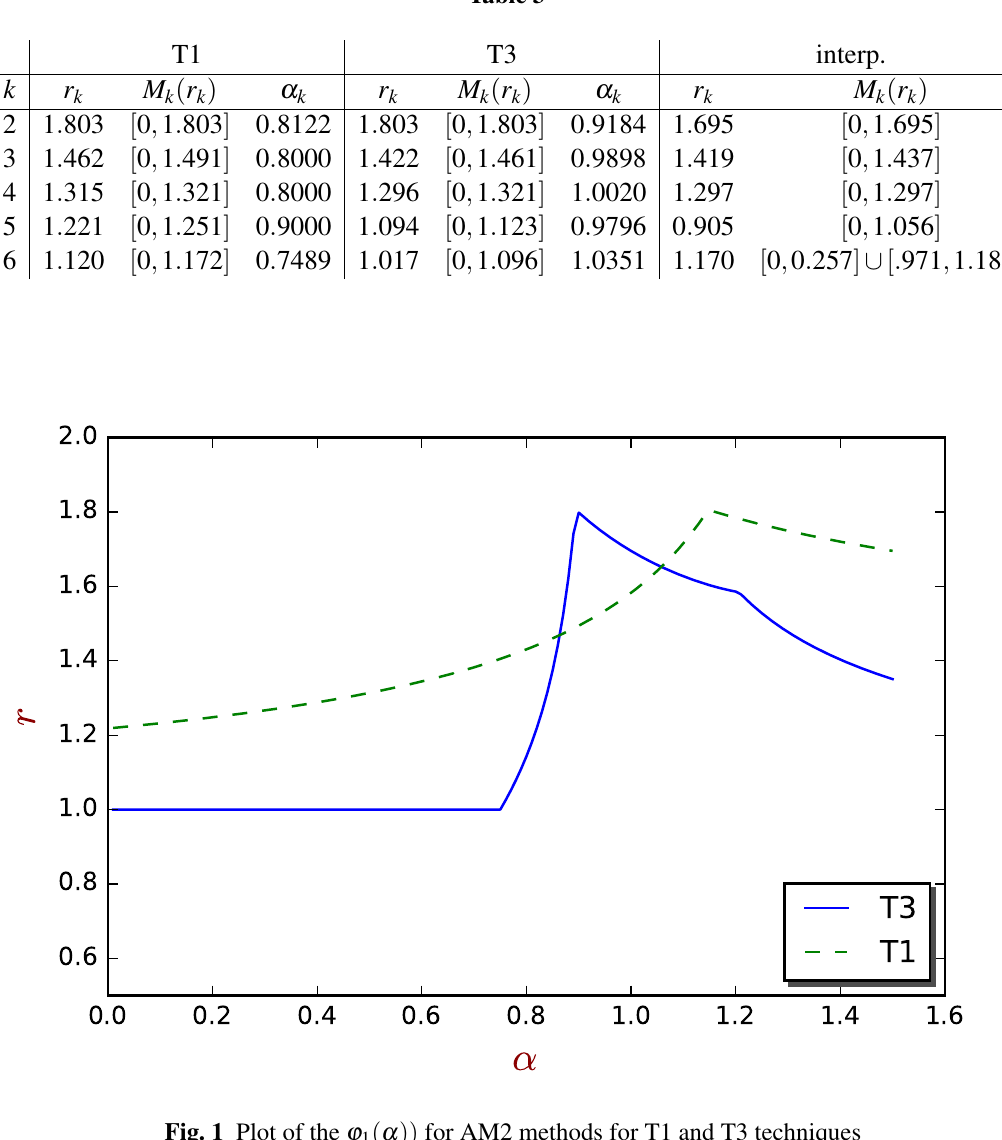
Fig. 1 Plot of the ϕ 1 ( α )) for AM2 methods for T1 and T3